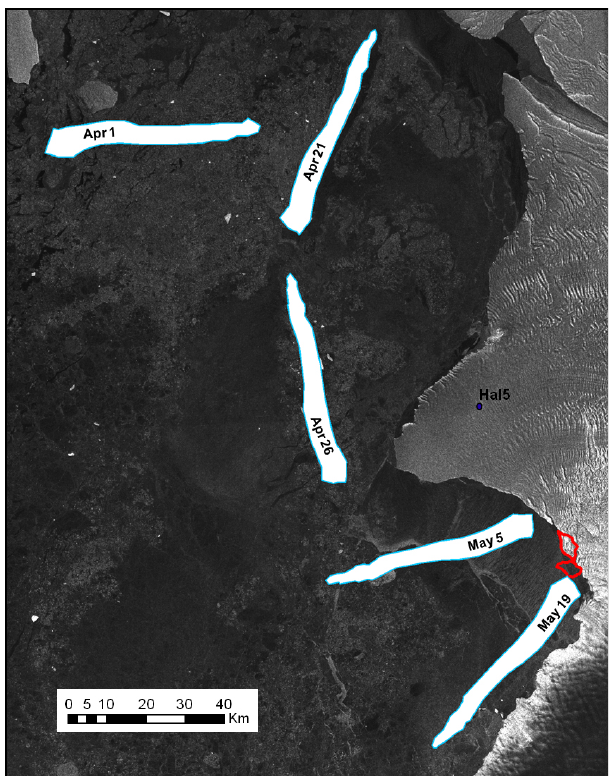
Fig. 6. The path of iceberg B-15K in early 2010. Note the long pe- riod of minimal drifting between 1 and 21 April, and the abrupt southerly motion between 21 April and 28 April. In May, the ice- berg made contact and caused an 18km 2 region of the BIS to calve off, as indicated with the outlines, lower right.